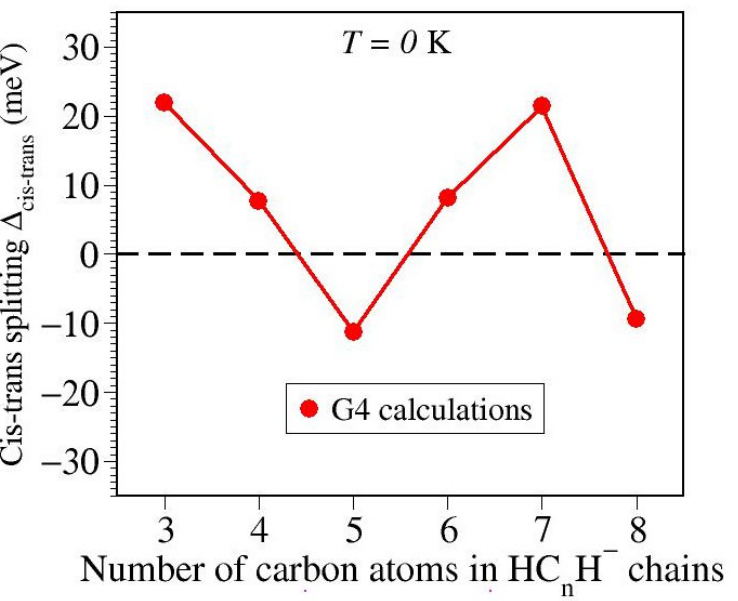
(cid:0) (cid:1) − ∆ (cid:0) (cid:1) 0 HC n H − HC n H − f H trans cis